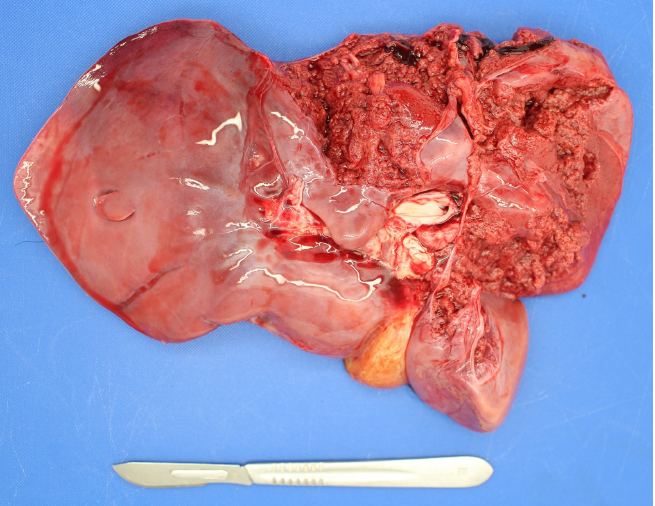
Figure 2. Hepatic rupture in a foetus infected with Listeria monocytogenes. Mycoplasma Species Mycoplasma spp. are rarely tested for and when they are, are rarely detected in PM studies, e.g., none of 121 PM cases yielded mycoplasma spp. though a small percentage